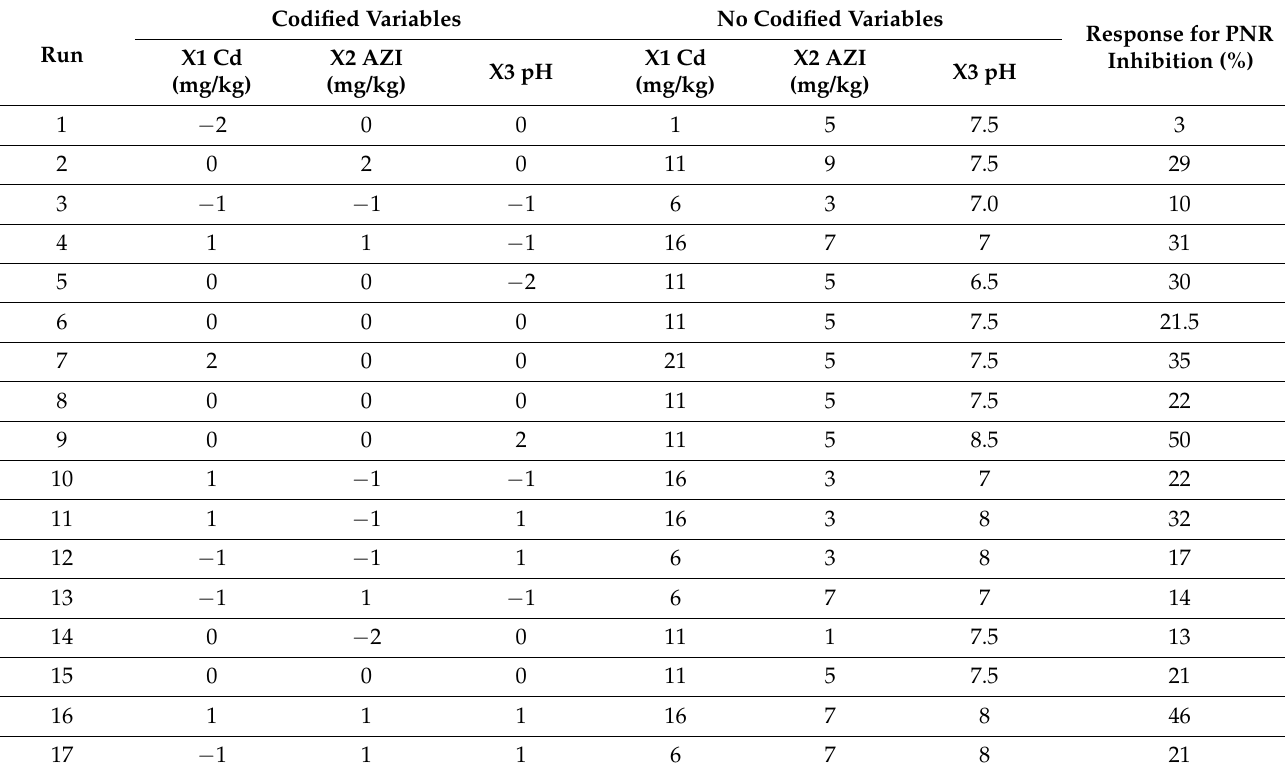
Table 4. Design matrix and observed